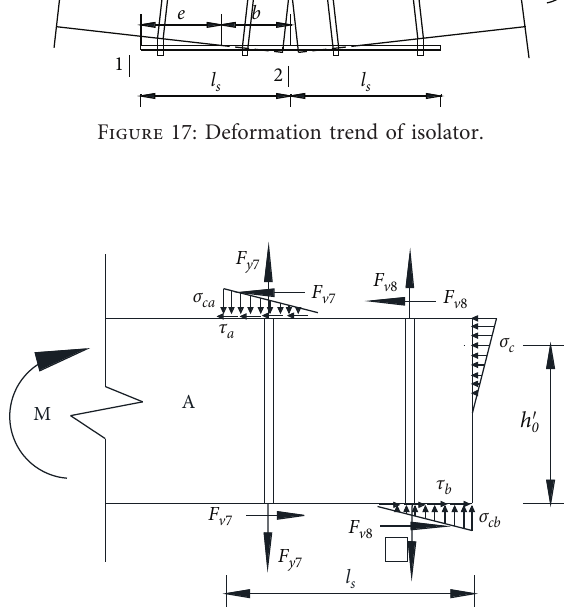
Figure 18: Stress condition of prefabricated component A.